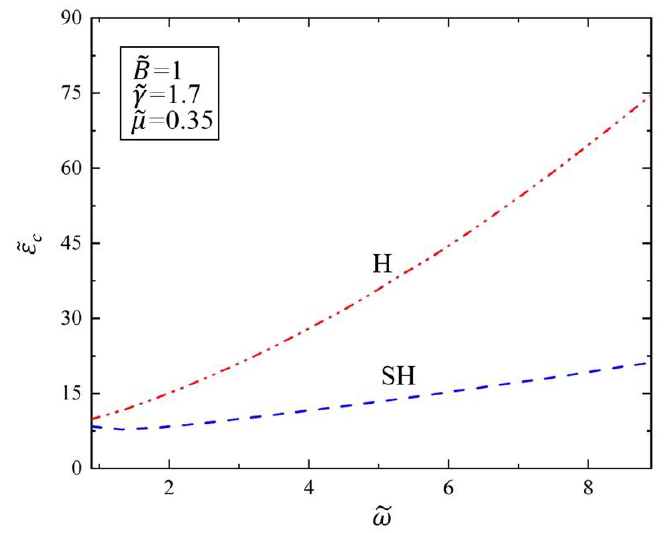
  of the Faraday instability with driving frequency c   1.7    0.35   1 B  . The critical amplitude  , ,   increases.